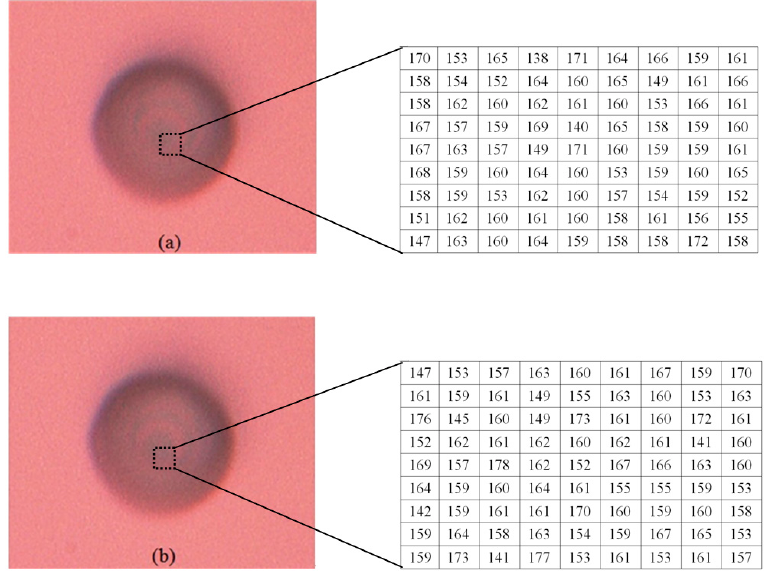
Figure 16. The blurred images of the microlens (the intensity values in the dotted rectangles are presented with two matrixes). ( a ) The blurred image before the platform is raised; ( b ) The blurred image after rising the platform.